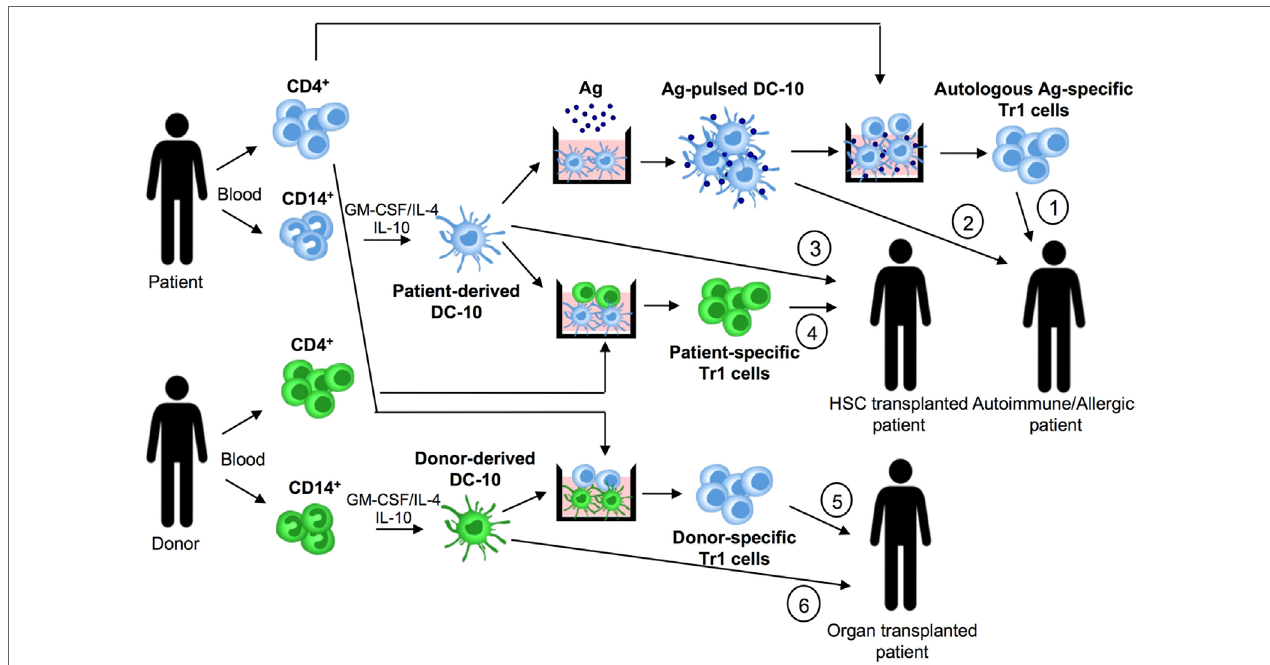
FigURe 2 | DC-10 and cell therapy approaches. DC-10 are differentiated in vitro from CD14 + cells in the presence of GM-CSF/IL-4/IL-10. In allergy and autoimmunity, patient-derived DC-10 pulsed with the specific antigen (Ag) can be used to induce differentiation of autologous Ag-specific T regulatory type 1 (Tr1) cell products (1), or directly infused into patients (2). In hematopoietic stem cell (HSC) transplantation, patient-derived DC-10 can be used to differentiate patient- specific Tr1 cell products (3), or directly infused into transplanted patients (4). In solid organ transplantation, donor-derived DC-10 can be used to promote differentiation of donor-specific Tr1 cell products (5), or directly infused into transplanted patients